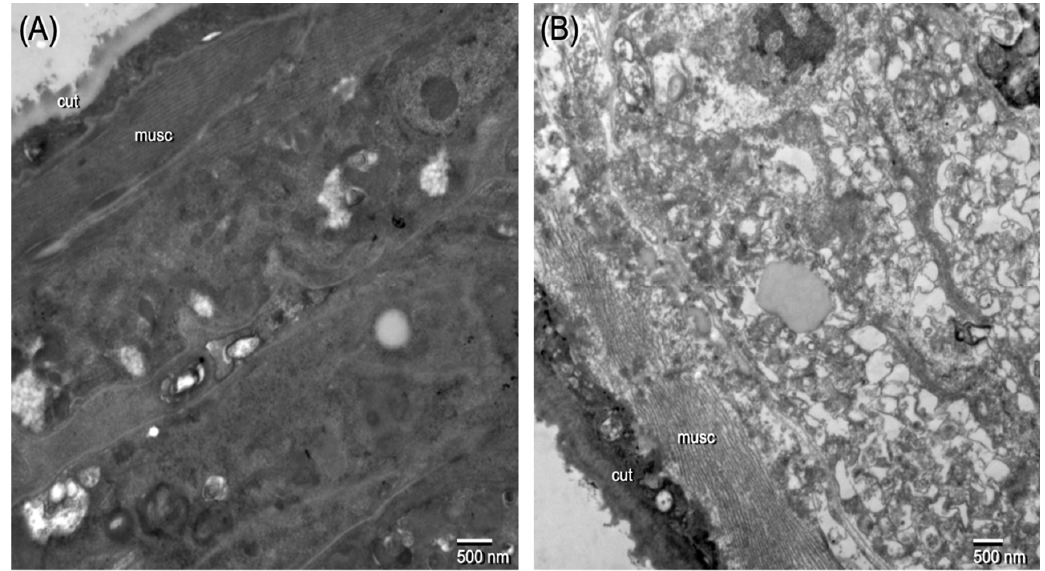
Figure 3. Microphotograph of ( A ) control and ( B ) THP treated Ov L5 from an in vitro assay. THP treated Ov L5 show cellular damage: vacuolization of cytoplasm, disrupted morphology of cellular content and cells lacking integrity. cut = cuticle; musc = muscle.